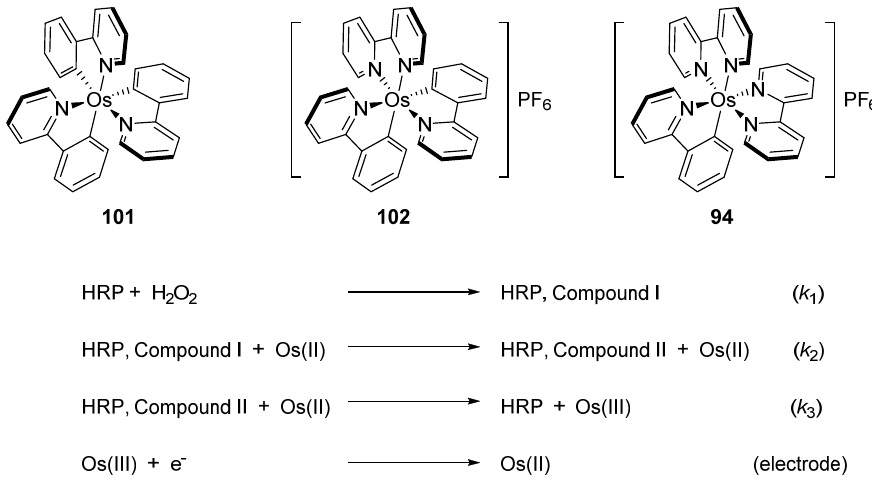
Figure 47. Mono -, bis -, and tris -cyclometalated complexes used as electron shuttles and electron transfer pathway with horseradish peroxidase (HRP).